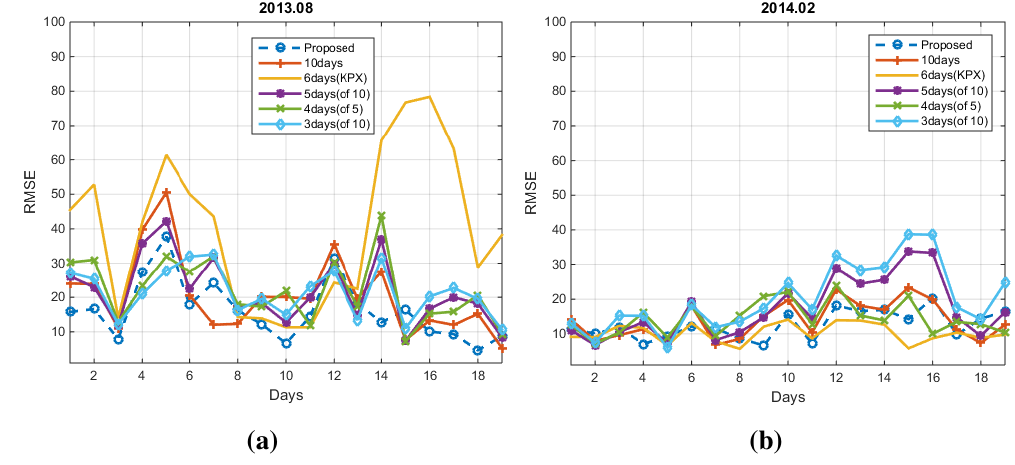
Figure 9. RMSE evaluation of site B in summer season ( a ) and winter season ( b ).